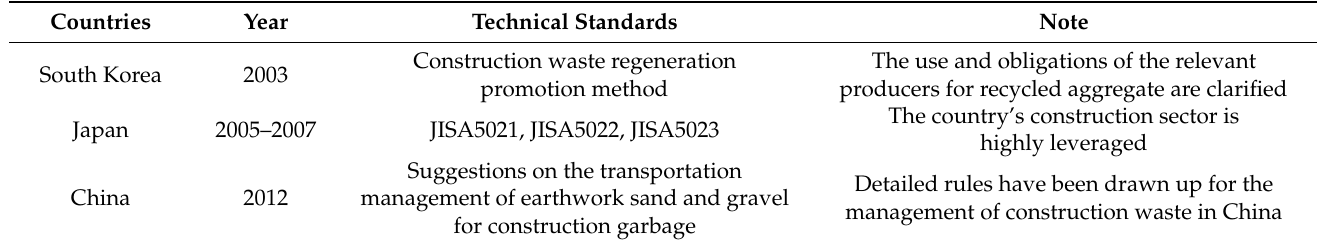
Table 2. Summary of standards and specifications for recycled concrete in various countries.